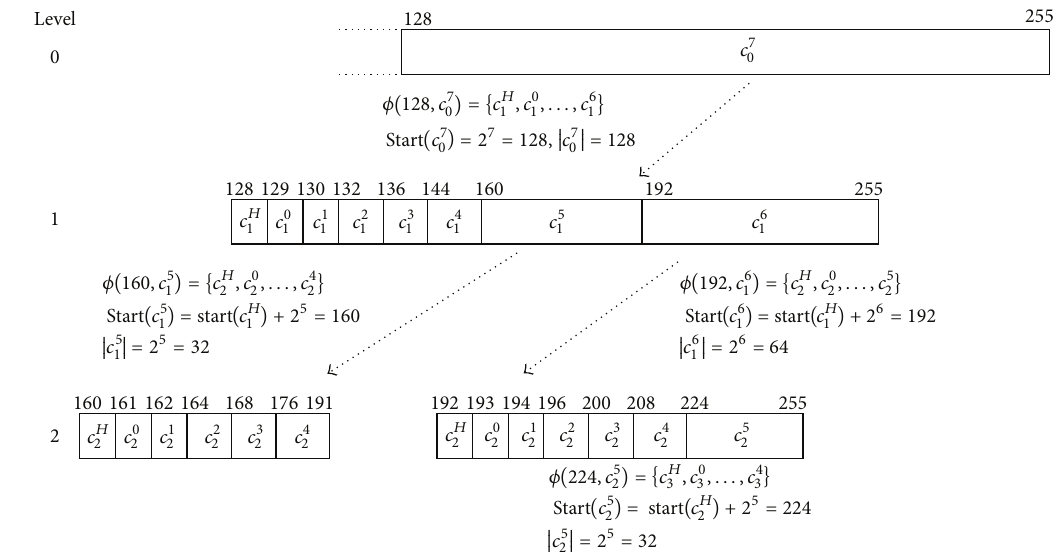
Figure 1: The chunk partitioning of